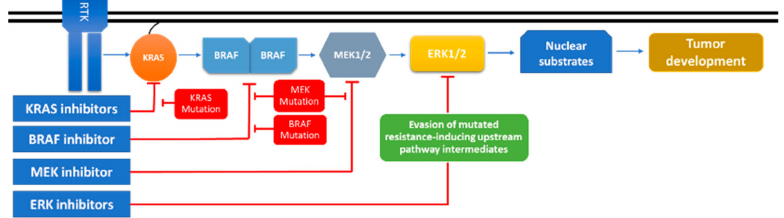
Figure 2. Mitogen-activated protein kinase (MAPK) inhibitor e ffi ciency based on mutational status—cause of resistance and weak spots. Treatment resistance is a reoccurring problem in the case of MAPK pathway inhibitors. The post-treatment acquirement or selection of tumor cells with new mutations renders the treatment useless. In the case of KRAS, BRAF, and MEK inhibitors, mutations in any of these two components can determine therapeutic resistance and relapse. Targeting ERK can become a true Achilles heel in treating cancers with MAPK signaling alterations, as ERK inhibitors target specifically downstream of the signaling cascade, with no regard of the mutational status of the upstream components (e.g., KRAS and BRAF) (KRAS: Kirsten rat sarcoma viral oncogene homolog; BRAF: B-Raf proto-oncogene serine / threonine kinase; ERK:extracellular regulated MAP